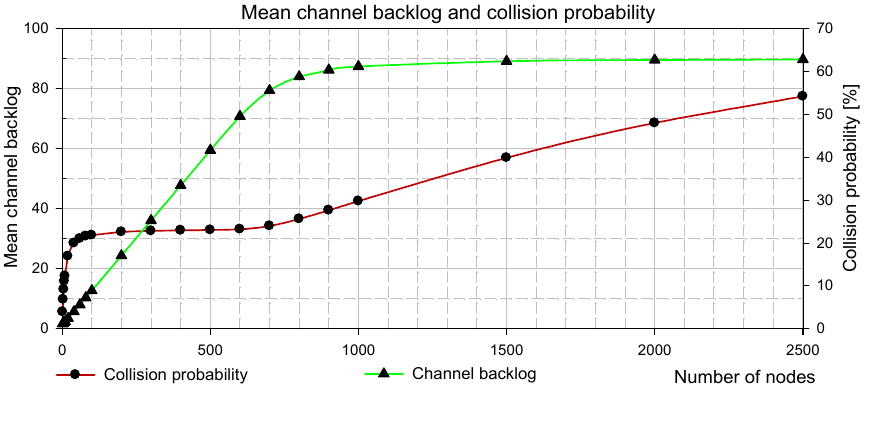
Figure 6. Mean channel backlog and the probability of a collision for ACK/unicast/CD load scenario. Three regions might be distinguished on the plot of the collision probability